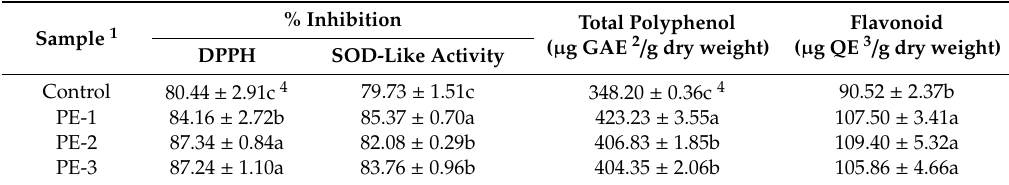
Table 6. 1,1-Diphenly-2-picrylhydrazyl (DPPH) and superoxide dismutase (SOD)-like activities and total polyphenol and flavonoid contents of soybean sprouts grown after seed-soaking in di ff erent concentrations of Pu-erh tea